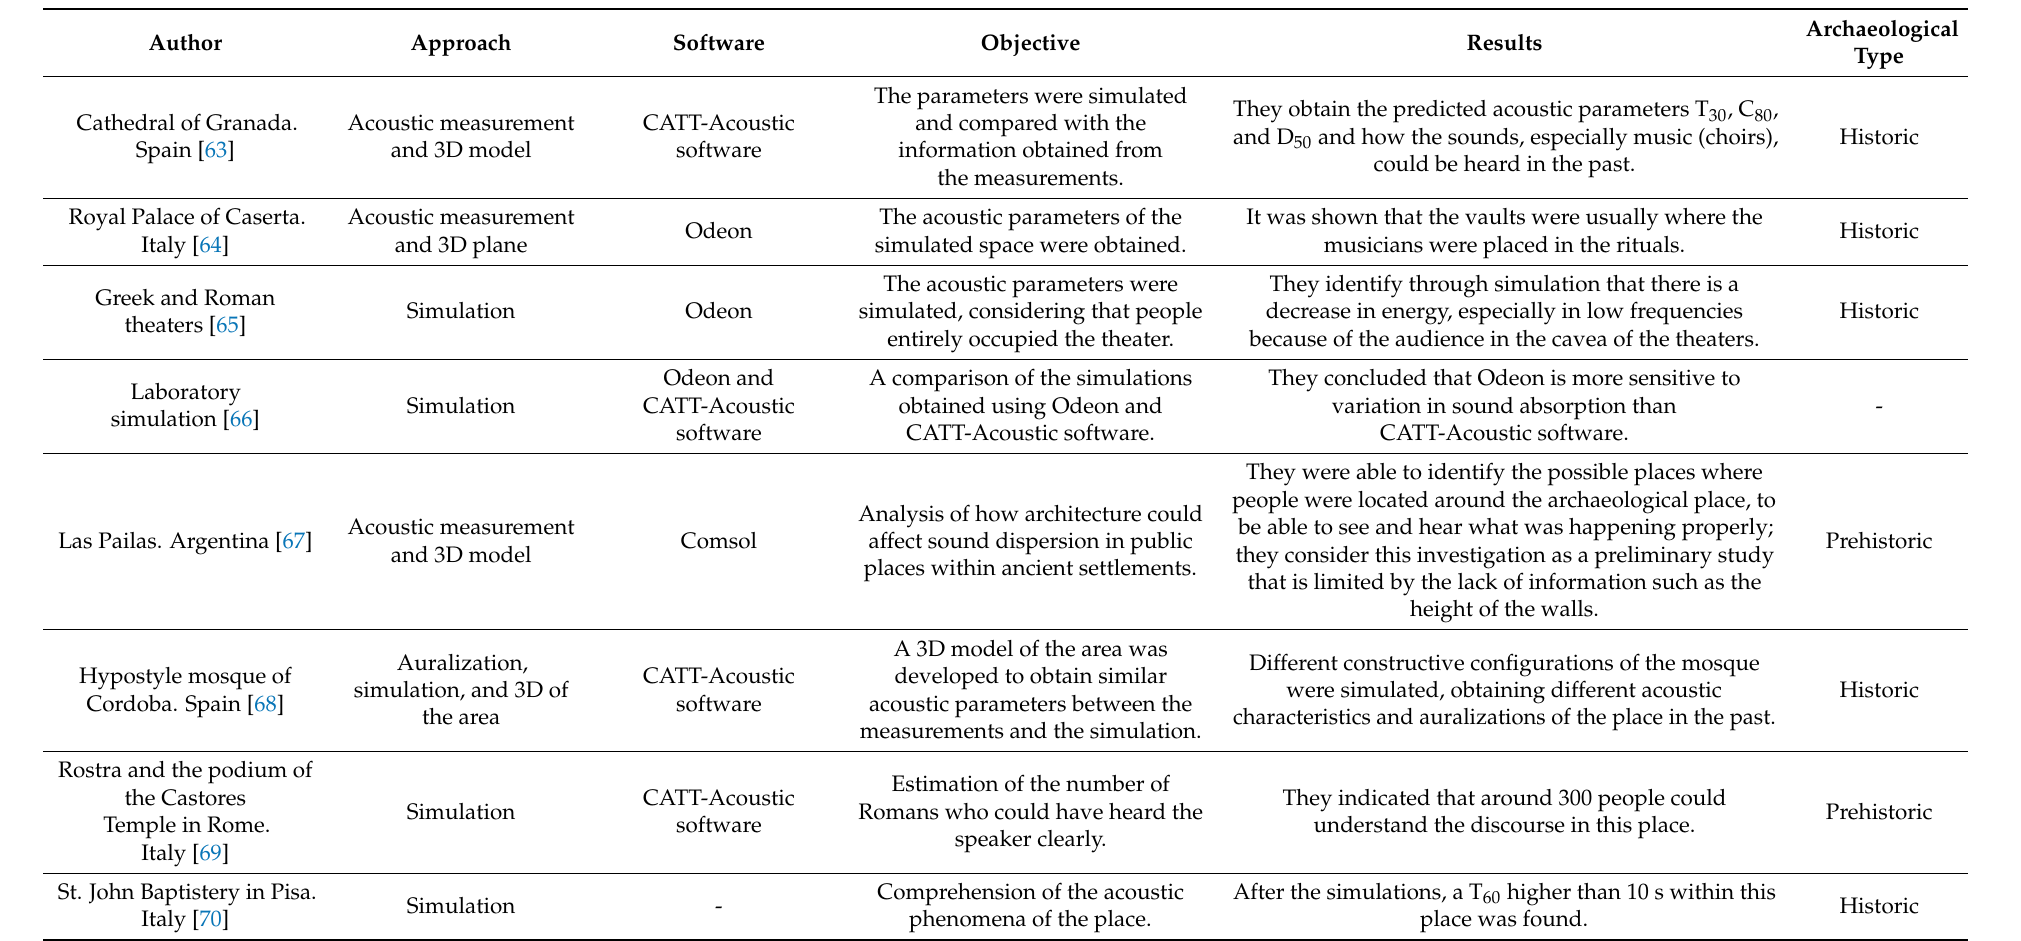
Table 4. Systems and procedures used in simulation, auralization, and virtualization studies